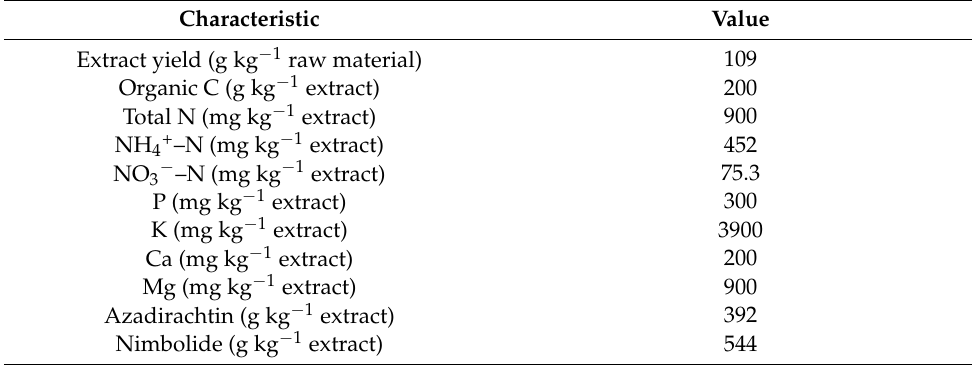
Table 2. Characteristics of the neem leaf